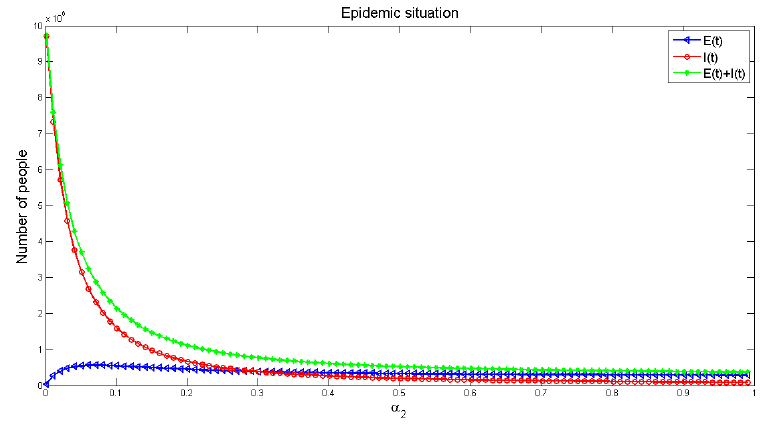
Figure 13. The effect of recovered rate α 2 on the number of infected people.